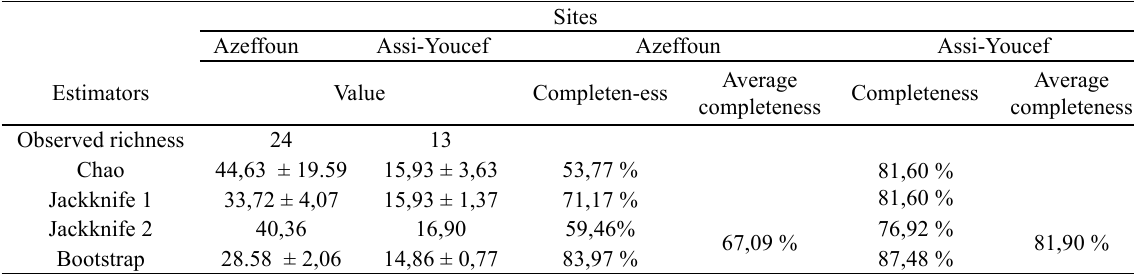
Table 4. Estimation of the total richness of the